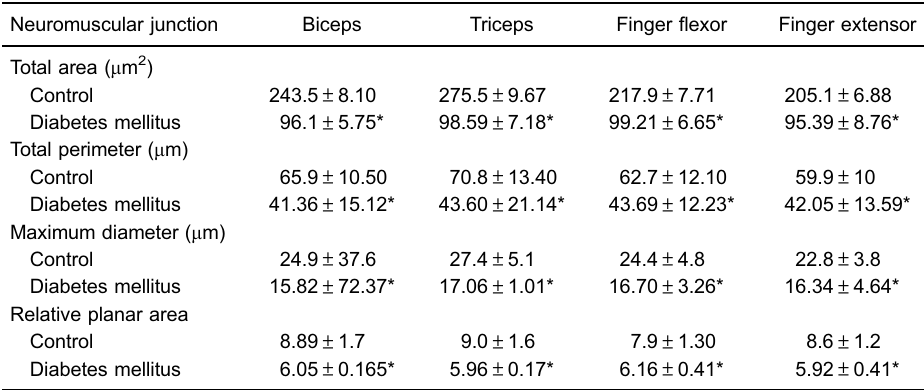
Table 1. Morphometric characteristics of neuromuscular junction of biceps, triceps, fi nger fl exor, and fi nger extensor muscles.